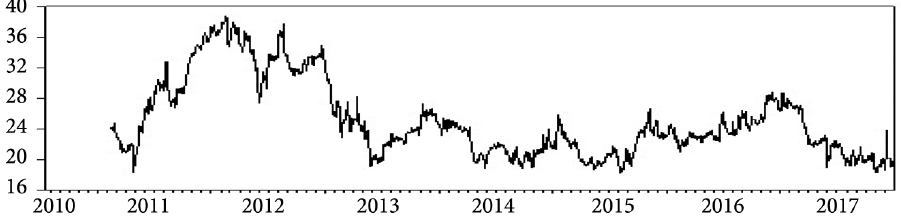
Figure 1. Average spillover index – U.S. bitcoin and financial